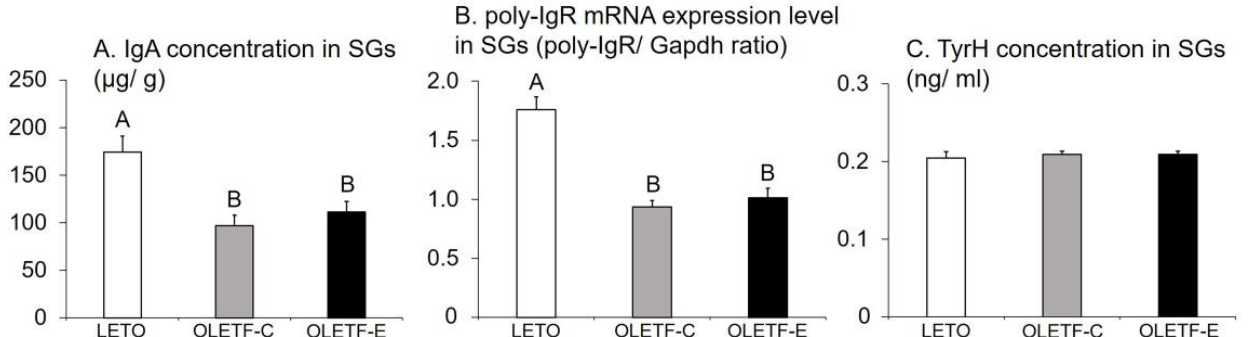
Figure 6. IgA concentrations ( A ), poly-IgR mRNA expression level ( B ), and TyrH concentration ( C ) in the submandibular glands (SGs) 16 weeks after the start of this study. n = 5 per group. The bars represent mean values, and the error bars represent SE. Significant differences were determined using the one-way ANOVA, followed by multiple comparisons using Tukey’s post-hoc test. The letters represent significant differences between groups ( p < 0.05, Tukey’s post-hoc test).